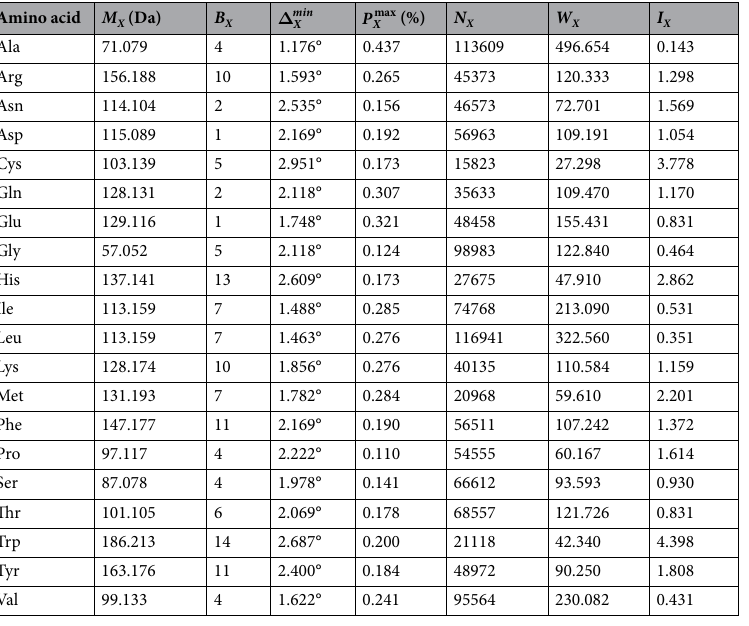
Table 1. Properties of the Amino acids used in the present study. M X is the residue average mass (without water). B X gives Davis’ biosynthetic steps 37 . Δ deg ( ) Xmin is the optimal bin angle determined by MISE method 17 . P X max corresponds to the peak of the Ramachandran distribution P X ( φ , ψ ). N X is the number of points used for determining P X ( φ , ψ ). = M X X / W X is the mutational inertia